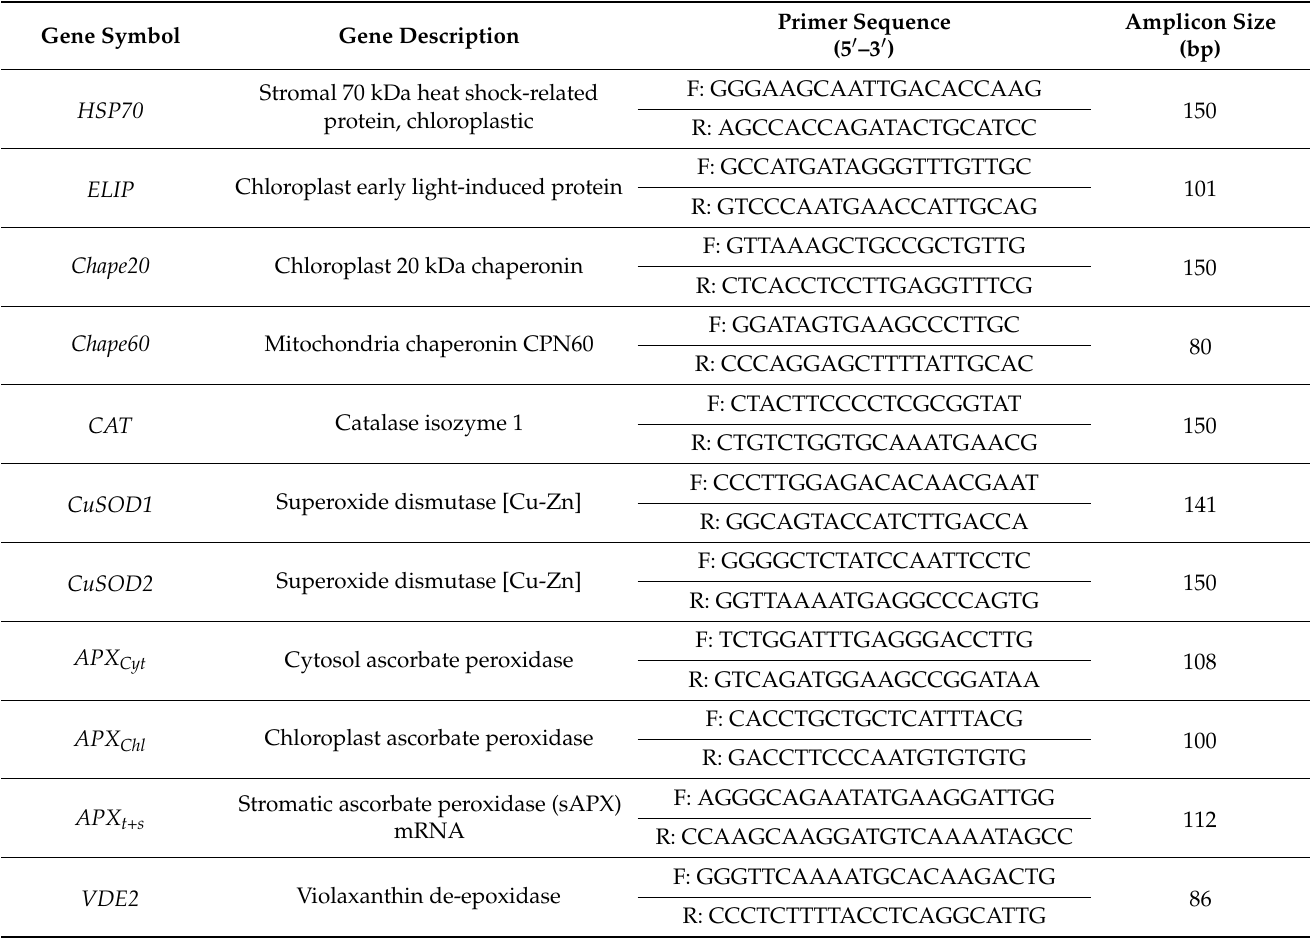
Table 3. Selected genes used for real-time qPCR studies related to protective mechanisms and/or oxidative stress control, primer sequences and amplicon size